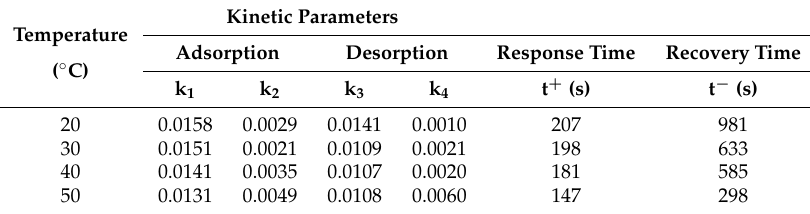
Figure 9. Time-dependent capacitance response at 20 ◦ C (red) and 50 ◦ C (orange) with Langmuir-based double-exponential fitting (black) for ( a ) adsorption of methanol and ( b ) desorption of methanol. Kinetic parameters versus temperature; ( c ) adsorption of methanol; ( d ) desorption of methanol. Table 4. Table of kinetic parameters and response/recovery time for